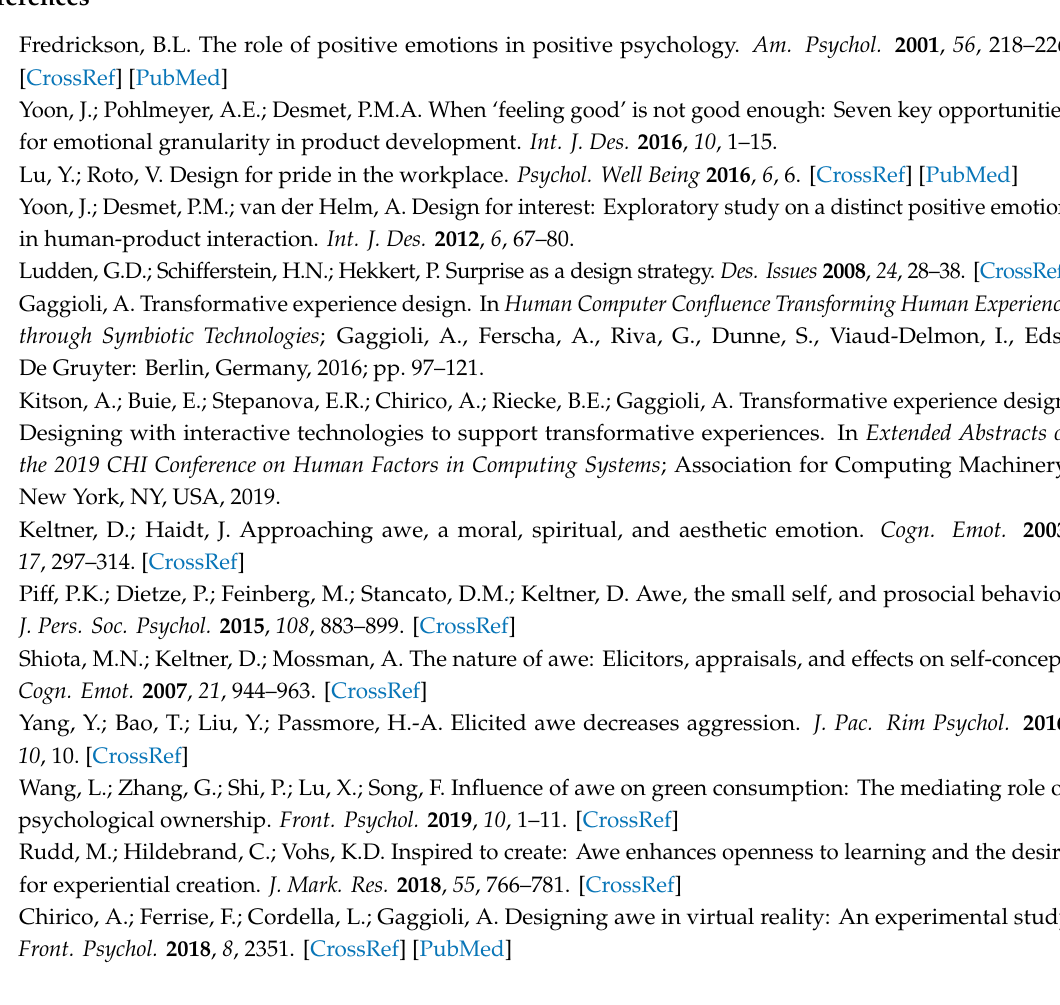
Figure 4c (Title: Light Evaporating with People II, Credit: teamLab, Exhibition view of teamLab Borderless, 2019, Shanghai © teamLab, courtesy Pace Gallery); Figure 4d (Title: Ice Watch, Credit: Ice Watch, 2014, by Olafur Eliasson and Minik Rosing, Martin Agryroglo photography); Figure 5a (Title: Ford 021C Concept Car, Credit: Ford 021C Concept Car, 1999, Marc Newson Ltd. and Ford, Tommaso Sartori photography); Figure 6d (Title: Drifter, Credit: Drifter, 2017, DRIFT and SkySpirit at Amory Show); Figure 7a (Title: Sunflower Seeds, Credit: Sunflower Seeds, Ai Wei Wei, 2010, Photo: © Tate, London 2020); Figure 7c (Reprinted by permission from Springer Science: Algebraic Topology: An Introduction, William S. Massey © 1977); Figure 8a (Title: Dreaveler, Credit: Dreaveler, 2018, by Taehoon Park at Pause Fest Motion Response 2018); Figure 8d (Title: Light My Fire, Credit: Light My Fire, 2008, by Florian Pittet, Ecal x SIGMASIX); Figure 9a (Beach House live at the House of Blues in Boston, 2018, by John Hutchings on Vanyaland.com. Link: https: // bit.ly / 2IEWVpm); Figure 9b (Title: Sketch Aquarium, Credit: teamLab, Exhibition view of teamLab Borderless, 2018, Tokyo © teamLab, courtesy Pace Gallery); Figure 9c (Title: Quarantine Stories, Credit: Quarantine Stories, 2020, by RNDR. Link: http: //